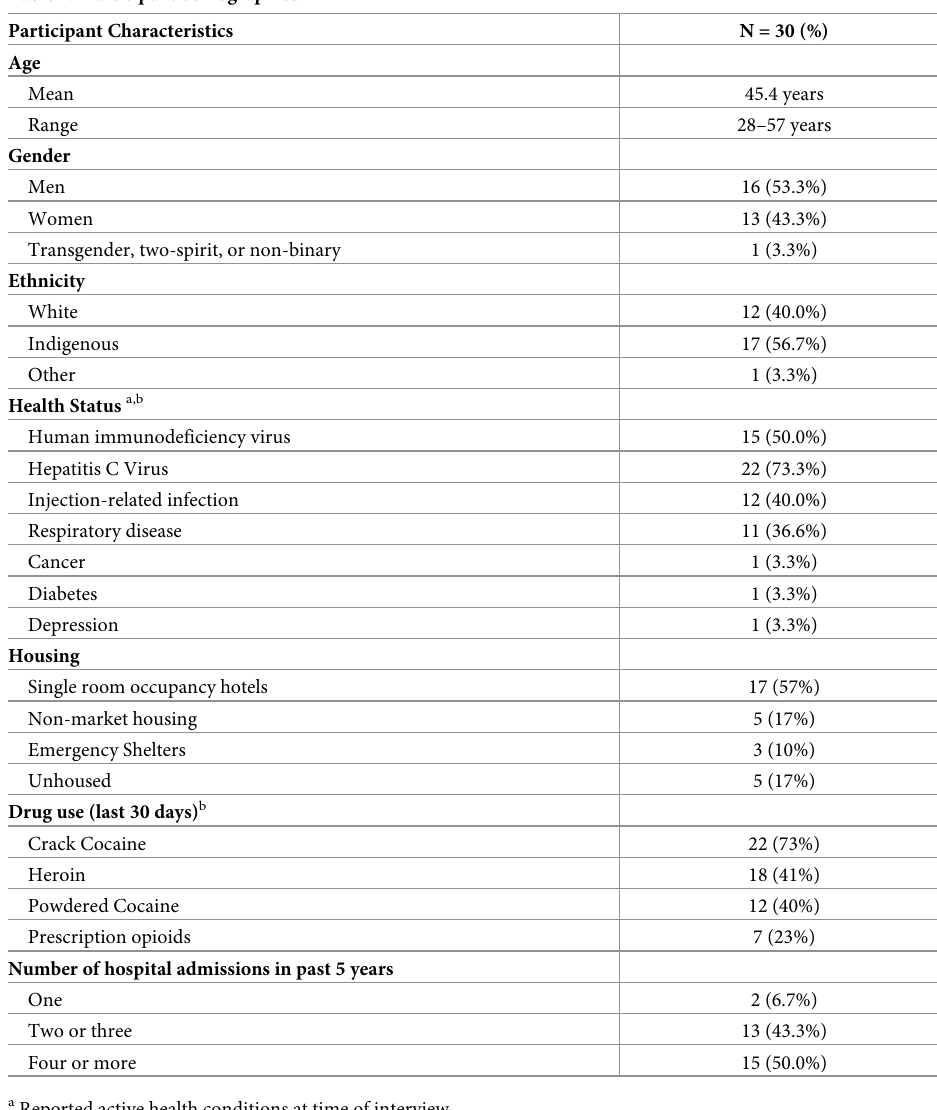
Table 1. Participant